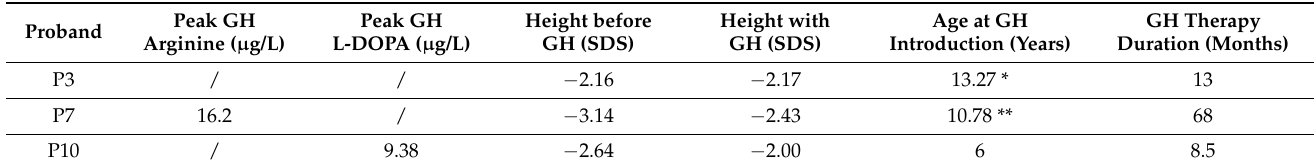
Table 2. GH stimulation testing with arginine and/or L-dopa results and growth follow-up in all participants receiving